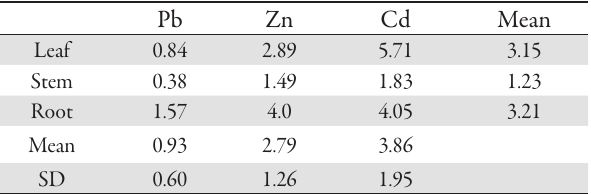
Tab. 3. Concentration factors calculated for different parts of A. marina and elements